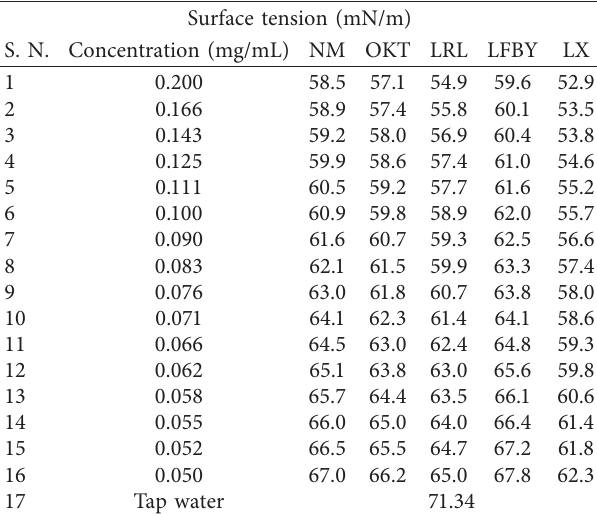
Figure 8: Graph representing the dependence of surface tension with the concentration: LFBY (closed circles), NM (squares), OKT (circles), LRL (triangles), and LX (closed squares). Table 3: Concentration versus surface tension of different soap